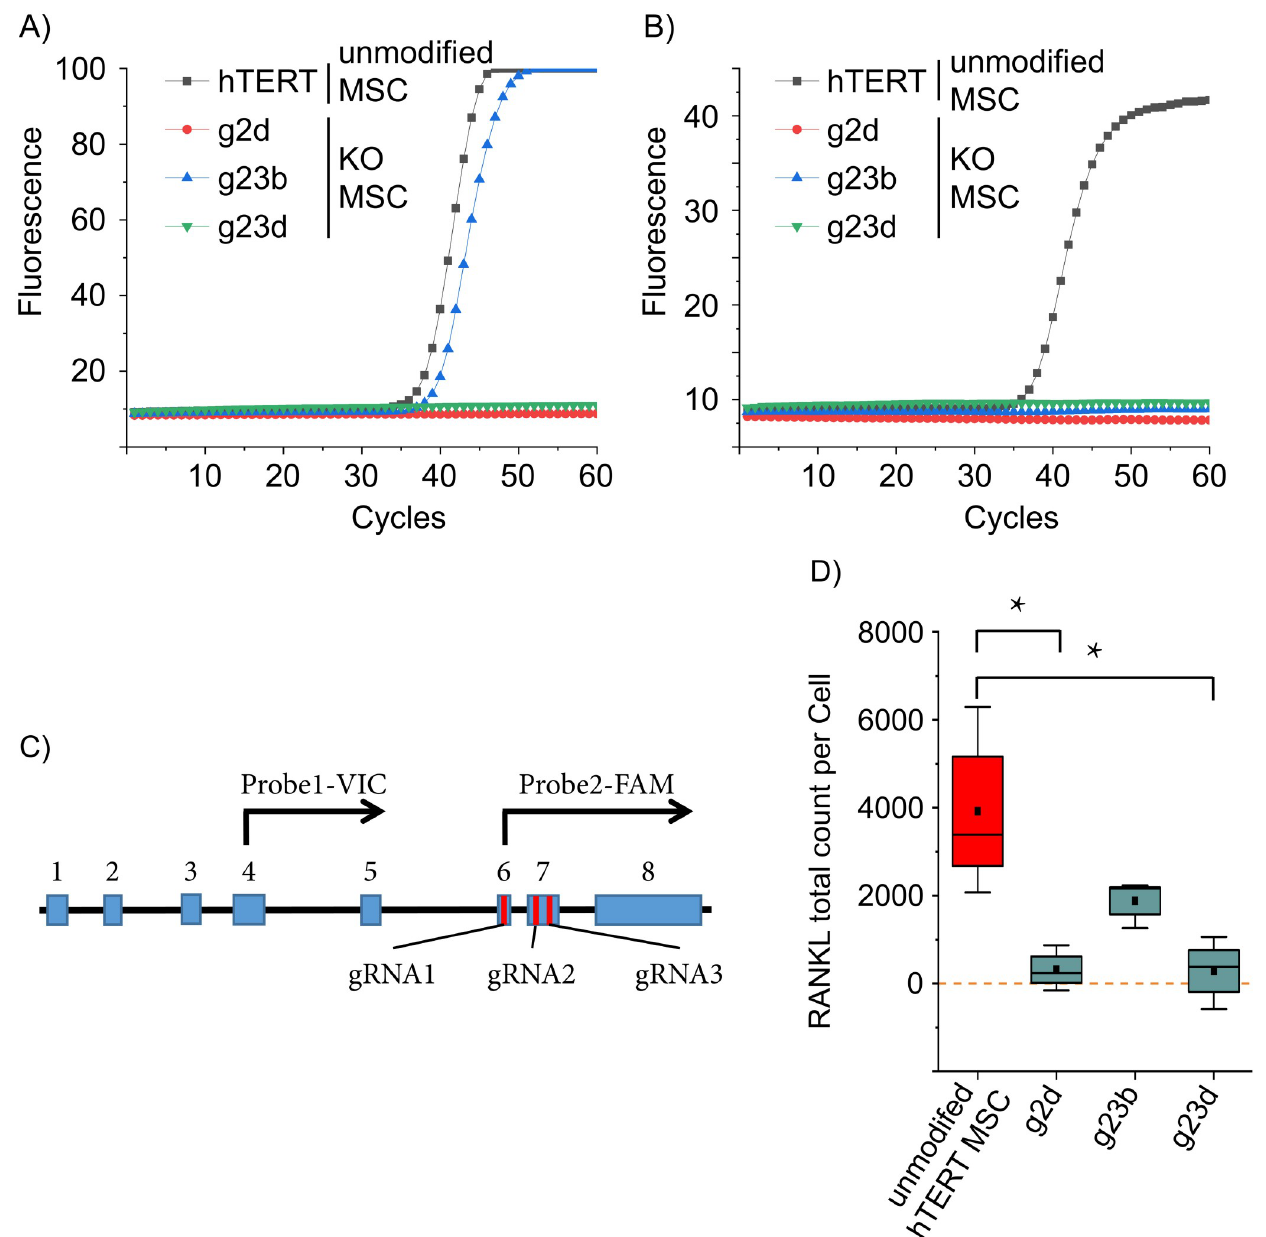
Fig 5. Quantitative measurement of TNFSF11 RNA and RANKL protein. TNFSF11 transcription was assessed by two qPCRs upstream (A) and downstream (B) of the gRNAs target sites. hTERT MSC and the TNFSF11 knockout clones g2d, g23b and g23d were analyzed (n = 3, representative runs are displayed). The upstream reaction was positive for hTERT MSCs and g23b, while the downstream reaction was positive only for hTERT MSCs. (C) Schematic presentation of the major splice variant of TNFSF11 . Blue boxes represent exons, red bars indicate the target site of the CRISPR/Cas9 gRNAs and black arrows symbolize the TaqMan probes with the respective fluorophore. (D) Protein expression was measured using Emulsion Coupling. RANKL- positive hTERT MSCs were applied as positive control and 3 different RANKL KO hTERT MSCs were analyzed. The results are in the absolute counts of detected RANKL proteins. The values were normalized against control reaction without interaction (ABC) (red = positive control, cyan = samples); boxes represent the interquartile range (IQR; first to third quartiles); whiskers are 1.5 × IQR; horizontal mid-line, median; dot, mean. Statistical significance is indicated: Kolmogorov-Smirnov-test (n = 3) � P < 0.05; zero level means no RANKL protein detected.